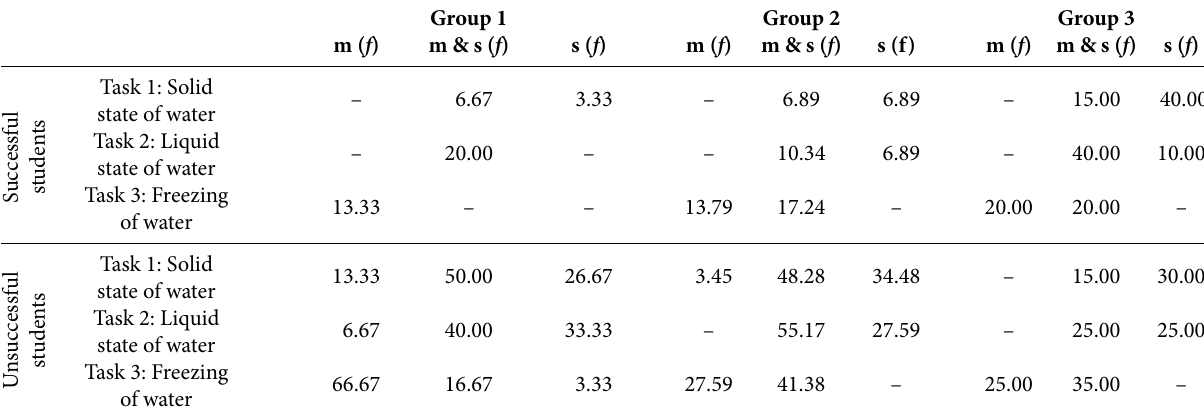
Table 2. Relative frequencies of successful and unsuccessful students’ arguments at a specific level of representation, m – macroscopic level; m & s – macroscopic and sub-microscopic level; s – sub-microscopic level. Group